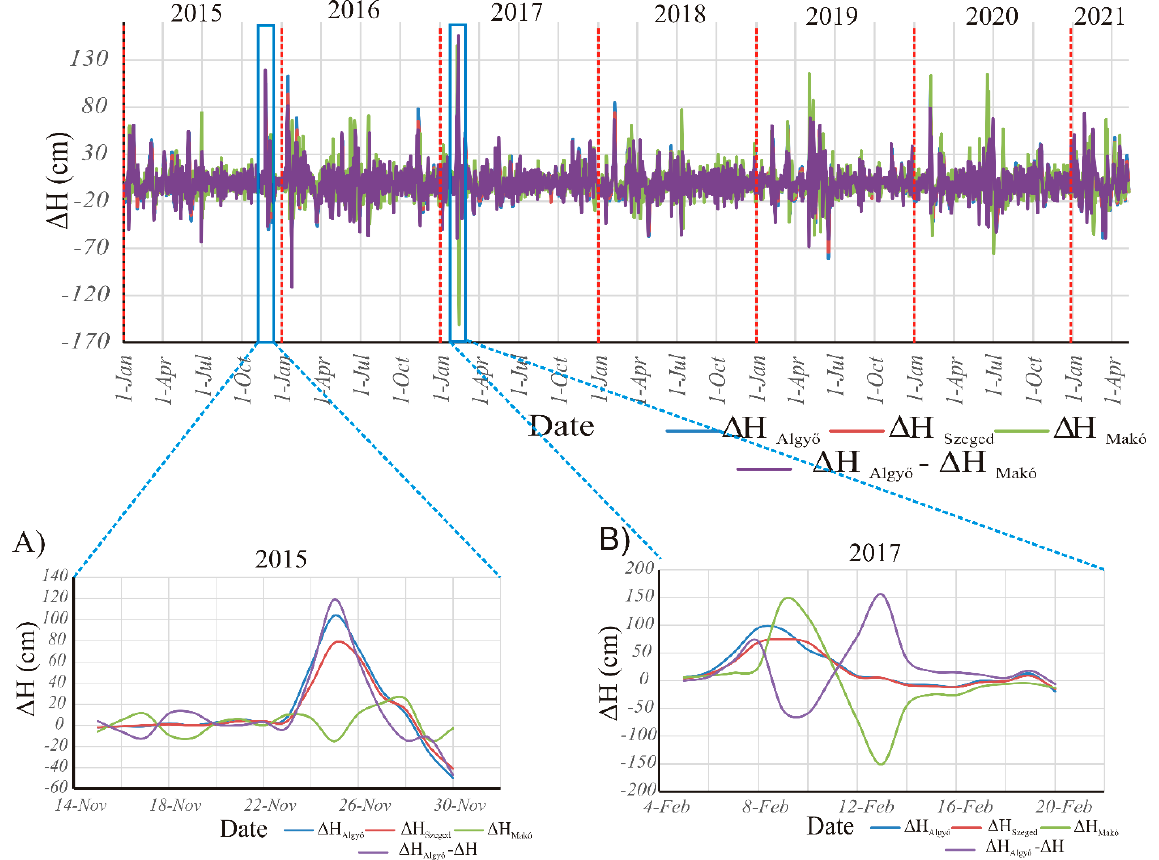
Figure A1. Calculated daily water stage change (cm/day) at the three gauging stations (Algy ő , Szeged, and Makó), and the daily difference change between Algy ő and Makó throughout the studied period (January 2015–May 2021). Zooming into flood events in November 2015 ( A ) and February 2017 ( B ), as an example of the greatest daily differences.